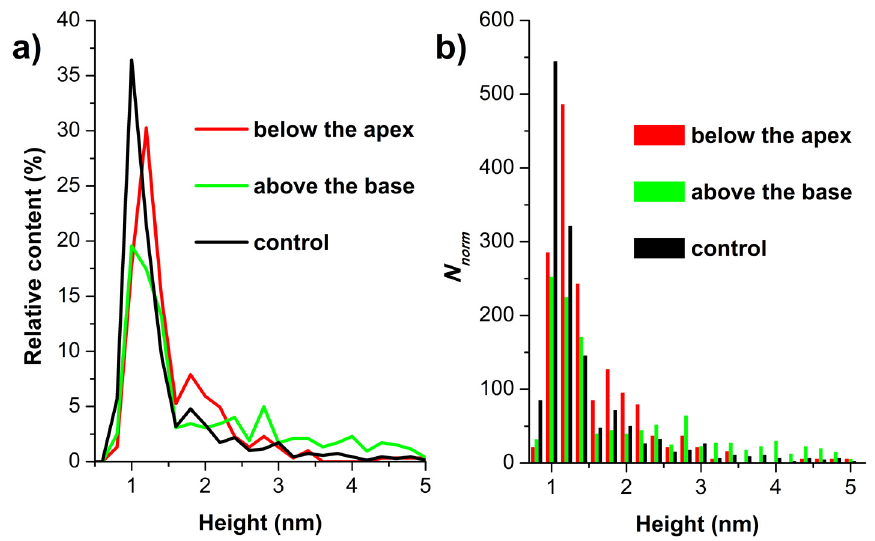
Figure 4. Results of processing the AFM data. ρ ( h ) curves ( a ) and N norm ( h ) histograms ( b ) obtained after analysis of AFM data obtained in our experiments for HRP adsorbed on mica from the solutions incubated 1 cm below the ISP’s apex (red), 1 cm above the ISP’s base (green) or three meters away from the ISP (black; control sample).